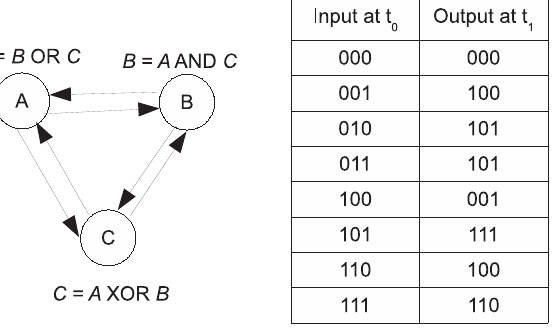
Figure 1. An example Boolean network and associated truth